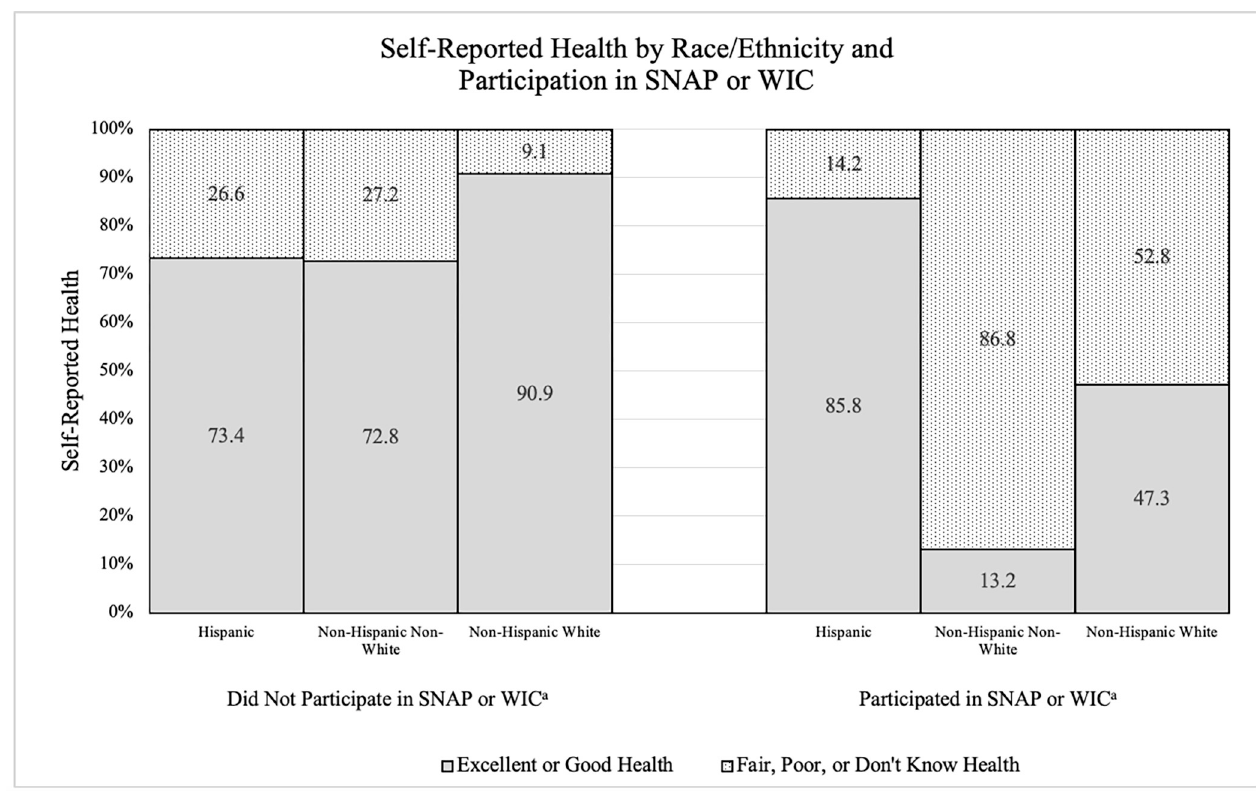
Fig 1. U.S. farmworker self-reported health status by race/ethnicity and SNAP or WIC participation: National Agricultural Workers Survey, 2009/2010 (n = 3691). a Indicated use of SNAP or WIC within two years prior.